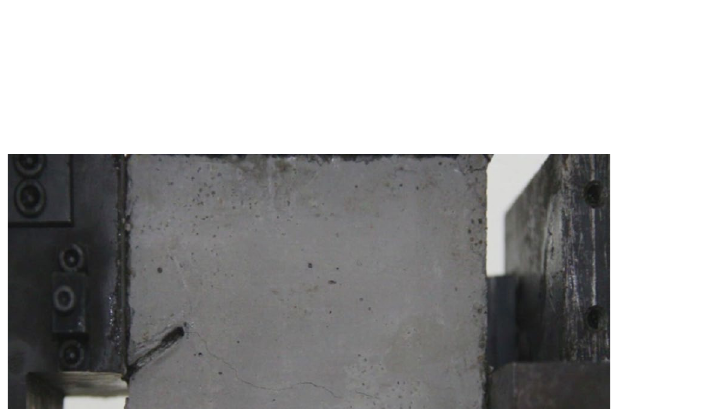
Figure 12. Photograph of a specimen showing fractures penetration.